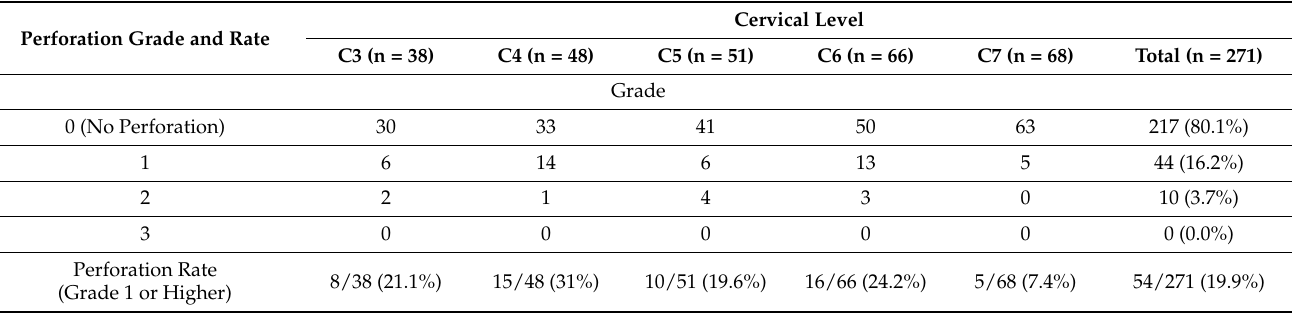
Table 2. Screw perforations at each cervical level.